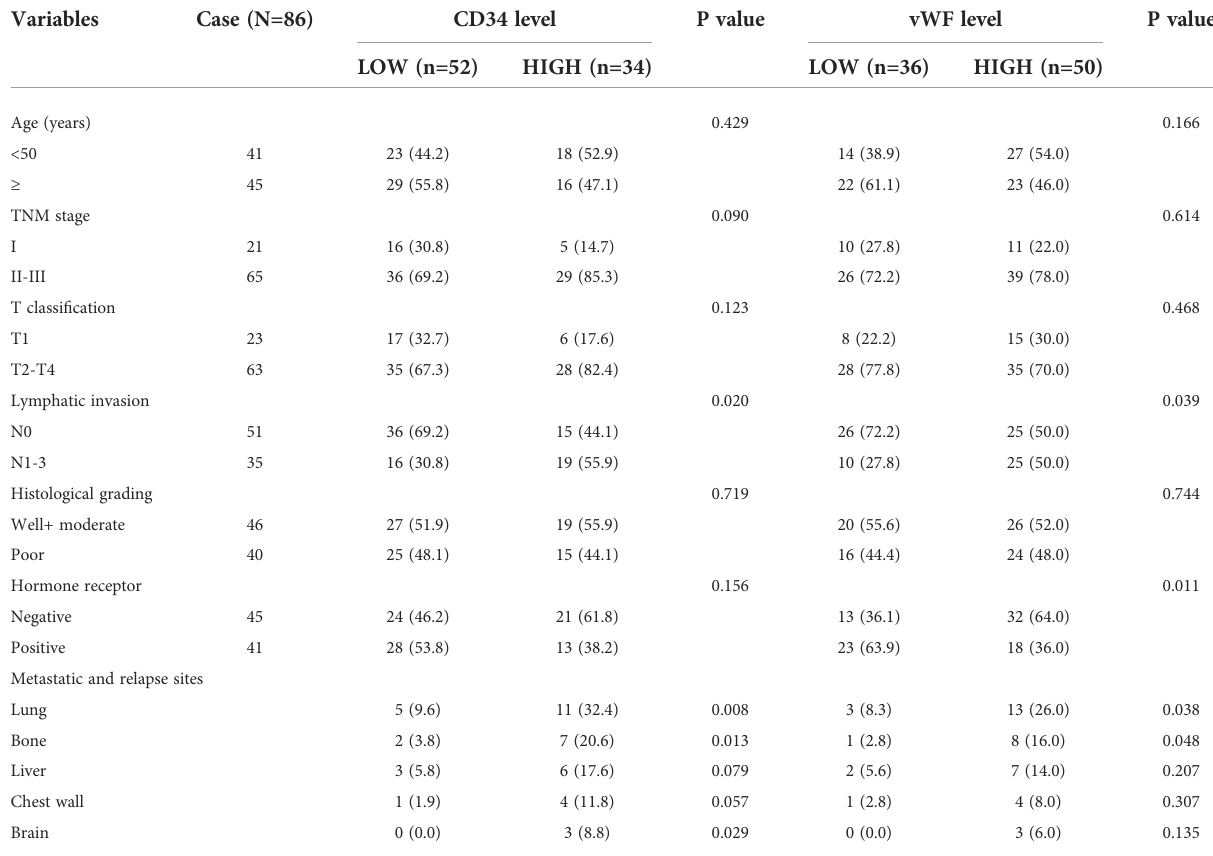
TABLE 1 Relationship between the expression of CD34, vWF and clinicopathologic parameters of IDC patients.